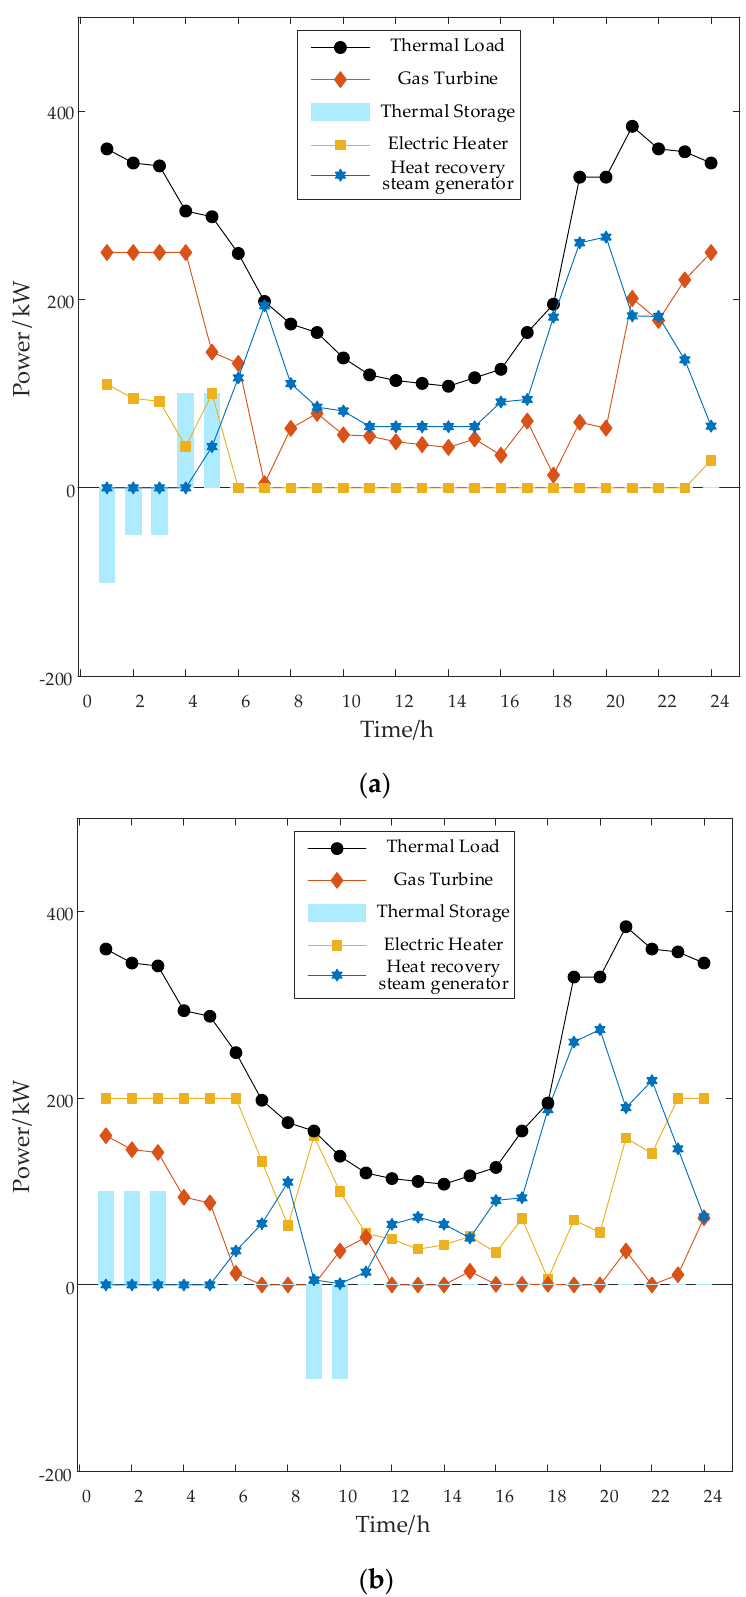
Figure 3. The power output on the electric bus before and after optimization: ( a ) before optimization; ( b ) after optimization.